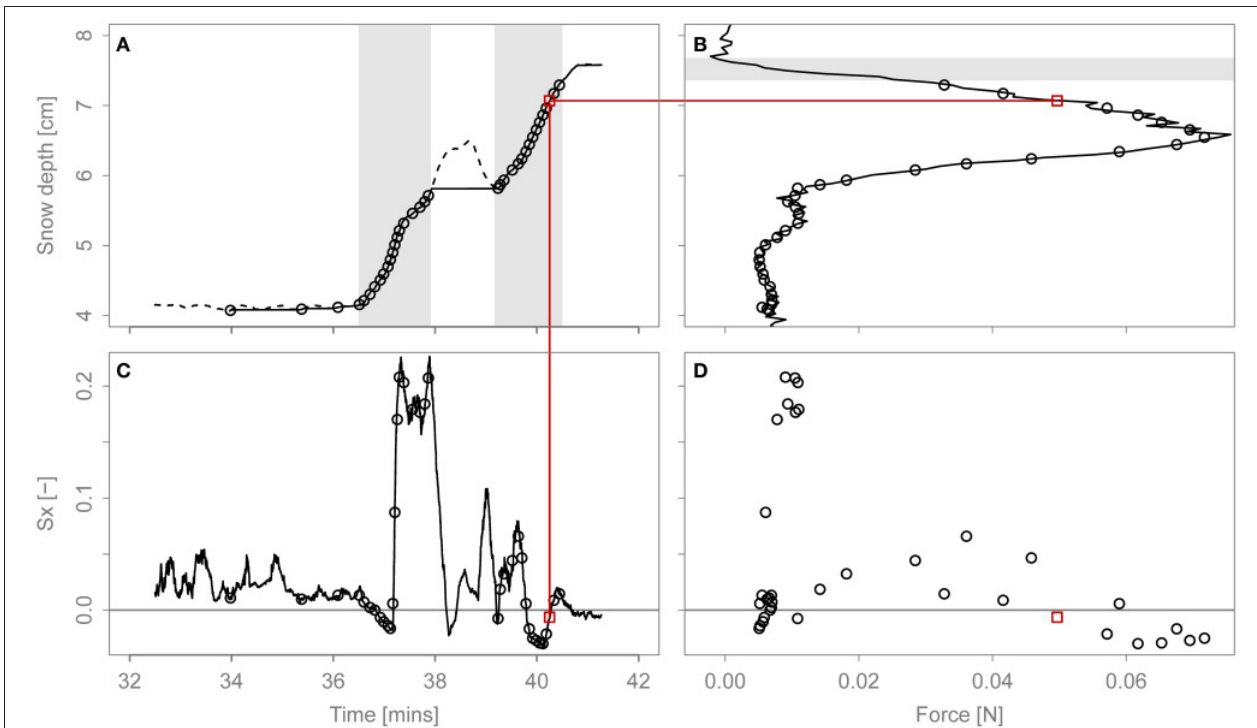
FIGURE 8 | Correlating the SMP force with Sx. (A) Depth-time mapping. The dashed line is the underlying snow depth data. It can be seen how the mapping splits the wind period in distinct deposition periods. The two main deposition periods are highlighted. The circles show the remaining points after the moving window filter is applied to the mapping. (B) SMP force profile. The neglected part of the profile close to the snow surface is highlighted (C) Sx as a function of time. (D) Scatterplot of Sx against force. The red line across the sub-plots shows for one filter window how the mapping in (A) connects force (B) with Sx (C) . The corresponding filter window is shown as a red square in all four